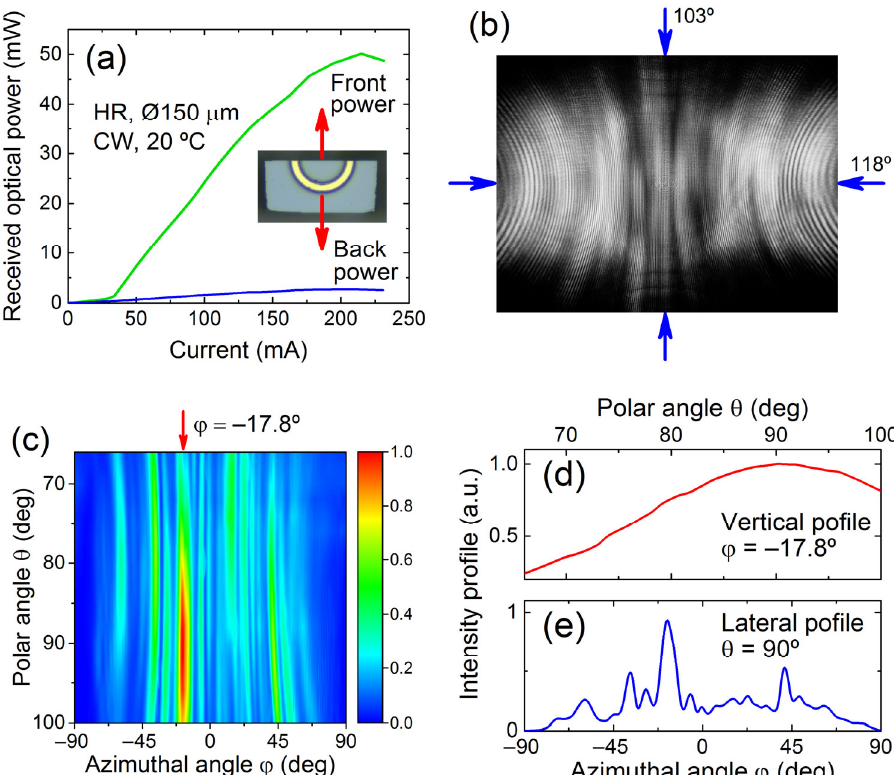
Figure 5. ( a ) The light–current curves for radiation emitted from cleaved edges (front power) and circular side (back power) of the Ø150 µ m HR. ( b ) A pattern formed on the CCD sensor by the radiation emitted from both edges of the Ø100 µ m HR in the lasing mode (the HR center is located opposite the sensor center; the plane of the HR heterolayers is oriented horizontally; approximate vertical and lateral radiation collection angles are marked in the figure). ( c ) Far field pattern of one edge of the Ø200 µ m HR in the lasing mode, measured with the goniometer (the normal to cleaved facet of the device corresponds to the azimuth angle φ = 0 and the polar angle θ = 90°), as well as the corresponding profiles in the vertical direction ( d ) at φ = –17.8° (for the brightest vertical stripe) and in the lateral direction ( e ) at θ = 90° (in the growth plane).